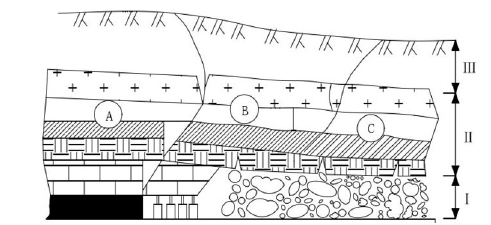
Figure 1: Distribution of the “ vertical three zones ” and “ horizontal three zones ” after overburden movement